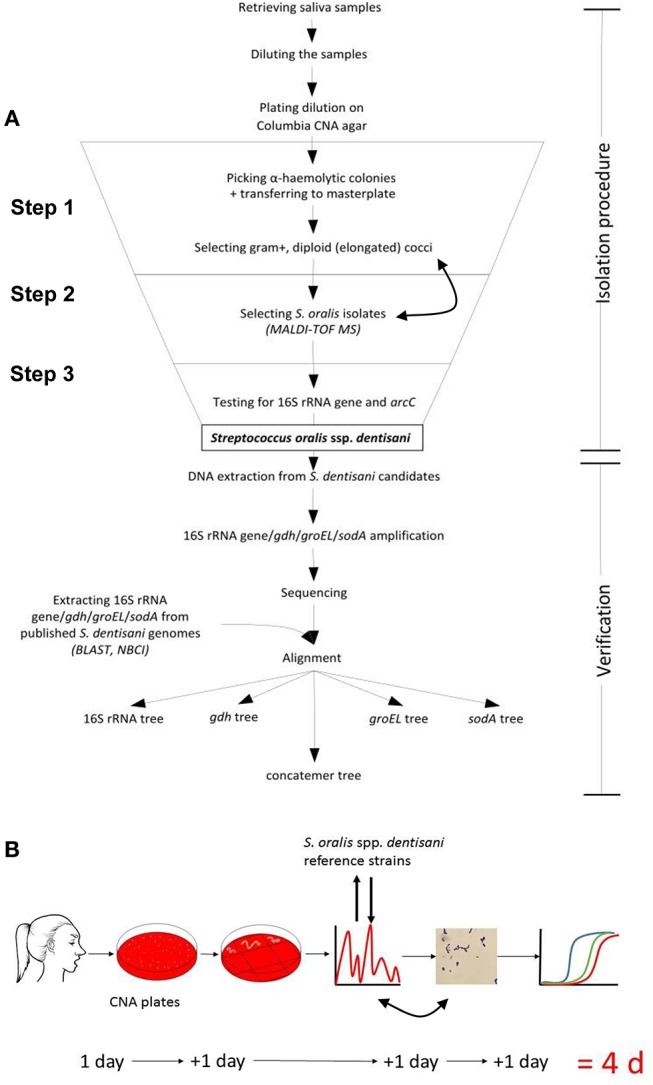
(A) Flowchart and (B) time-line for the isolation and verification procedure for human S. dentisani strains. CNA: Columbia colistin-nalidixic-acid blood agar plate (selective for gram-positive cells). Double arrows indicate that the MALDI-TOF and gram-staining sequence is interchangeable.